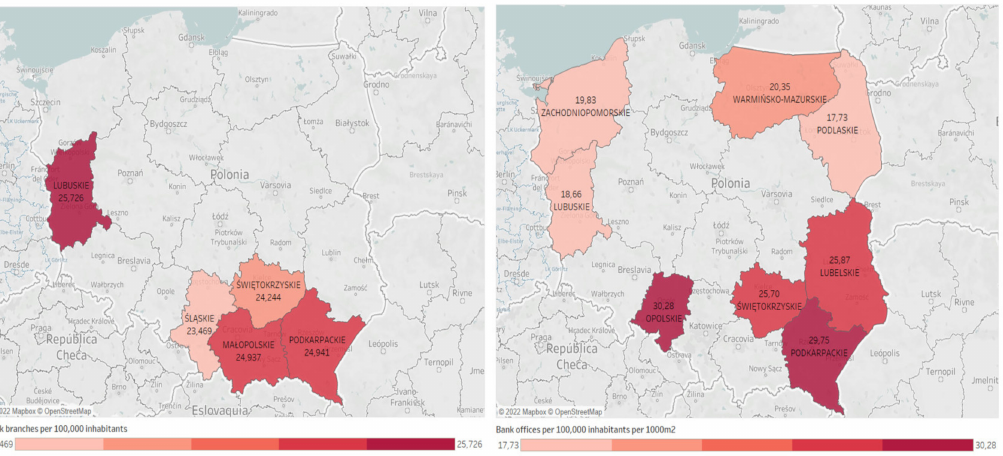
Figure 2. Voivodeships with the fewest bank offices per 100,000 inhabitants and the fewest bank offices per 1000 m 2 . Source: Own elaboration based on data from Table A1 and Tableau Desktop Professional